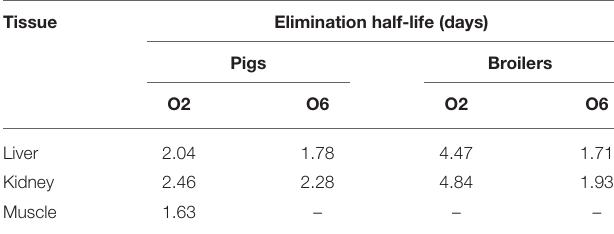
TABLE 2 | The elimination half-lives of O2 and O6 in the tissues of pigs and broilers after being fed with olaquindox for 14 consecutive days.